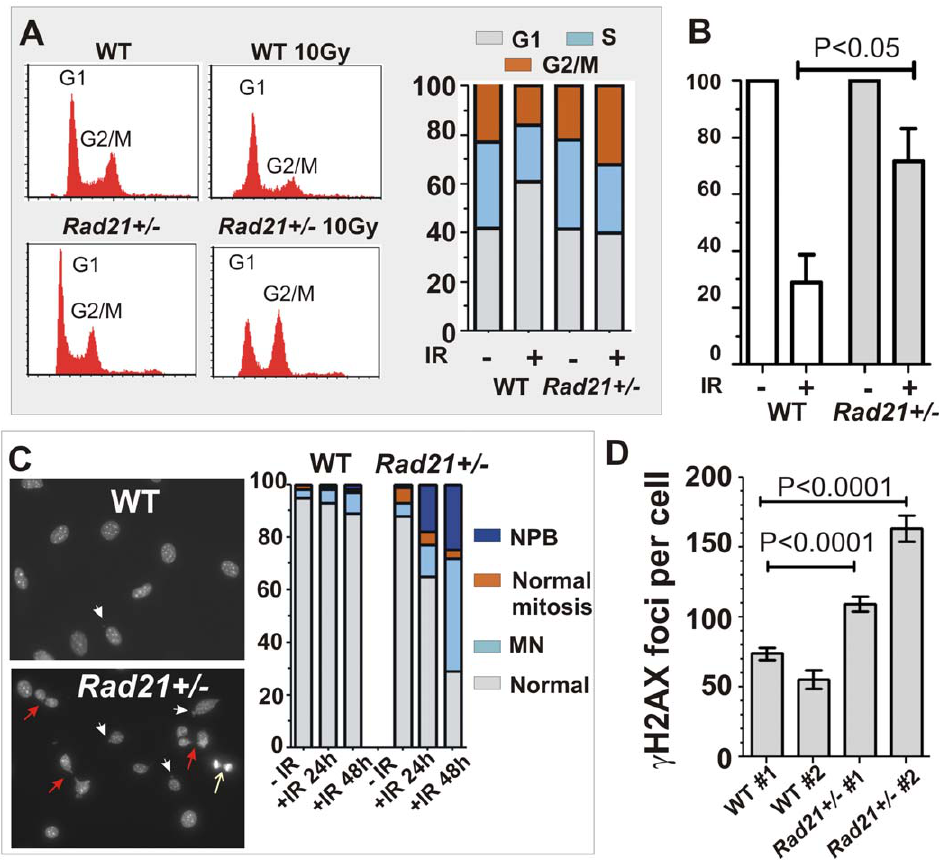
Figure 2. Radiation-induced DNA damage response of Rad21 + / 2 cells. A . Cell cycle profiles of WT and isogenic Rad21 + / 2 MEFs. Cells were analysed 24 hours post 10Gy IR, with unirradiated cells as controls. DNA content was used to determine the proportion of cells in different cell cycle phases. B . Change in the percentage of S-phase cells 24 hours post 10Gy IR. BrdU-positive cells were expressed as the percentage of unirradiated controls. Data represent means of three independently-derived MEF cell lines for each genotype. Error bars=SEM. C . Radiation-induced genomic instability. Nuclei were visualised by DAPI staining and scored at indicated time-points post 10Gy IR, for the presence of nucleoplasmic bridge (NPB, red arrows), micronuclei, MN (white arrowheads) and normal mitoses (white arrow). Also see Figure S4. The number of nuclei scored was as follows: WT unirradiated n=643, 24 hours post IR n=1131, 48 hours post IR n=263; Rad21 + / 2 unirradiated n=782, 24 hours post IR n=1298, 48 hours post IR n=246. D . Quantification of radiation-induced c H2AX foci 4 hours post 10Gy IR. Two independently-derived WT and isogenic Rad21 + / 2 MEF cell lines were used. The number of nuclei scored was as follows: WT # 1 n=172, WT # 2 n=303; Rad21 + / 2 # 1 n=232, Rad21 + / 2 # 2 n=104. Error bars=SEM.